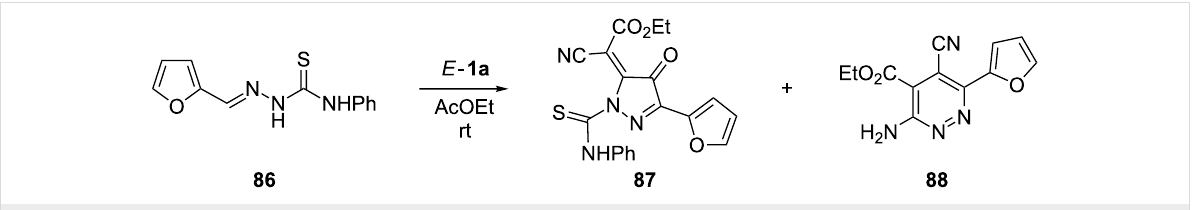
Scheme 27: Heterocyclization reaction of thiosemicarbazone 86 with E - 1a .